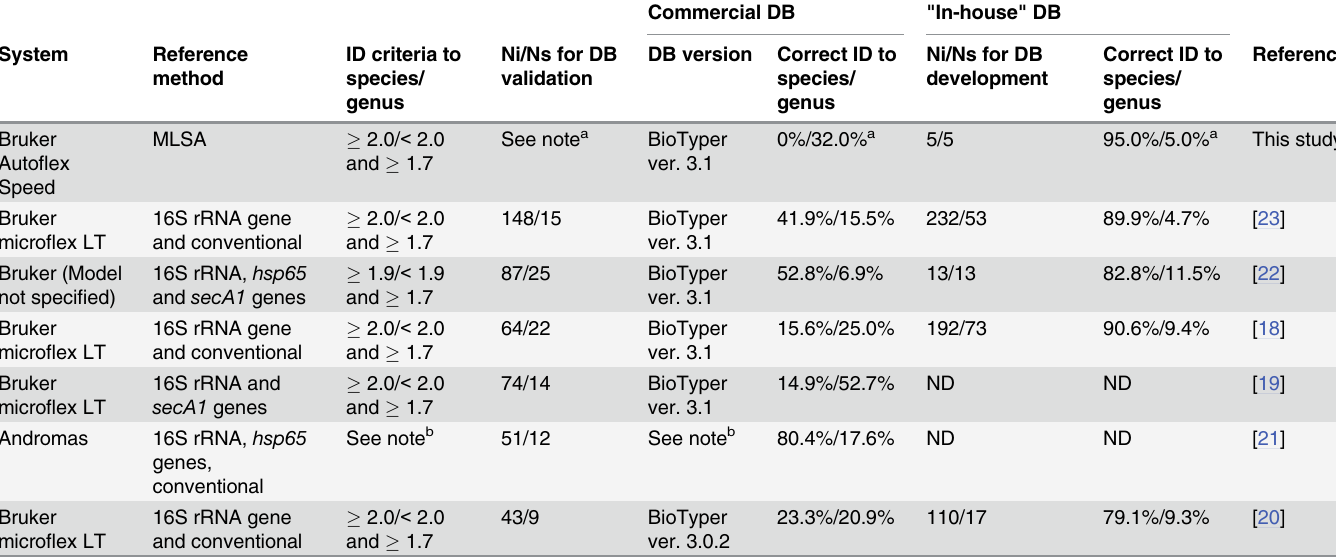
Table 4. Review of publications for evaluation of MALDI-TOF MS for the identification of Nocardia species.